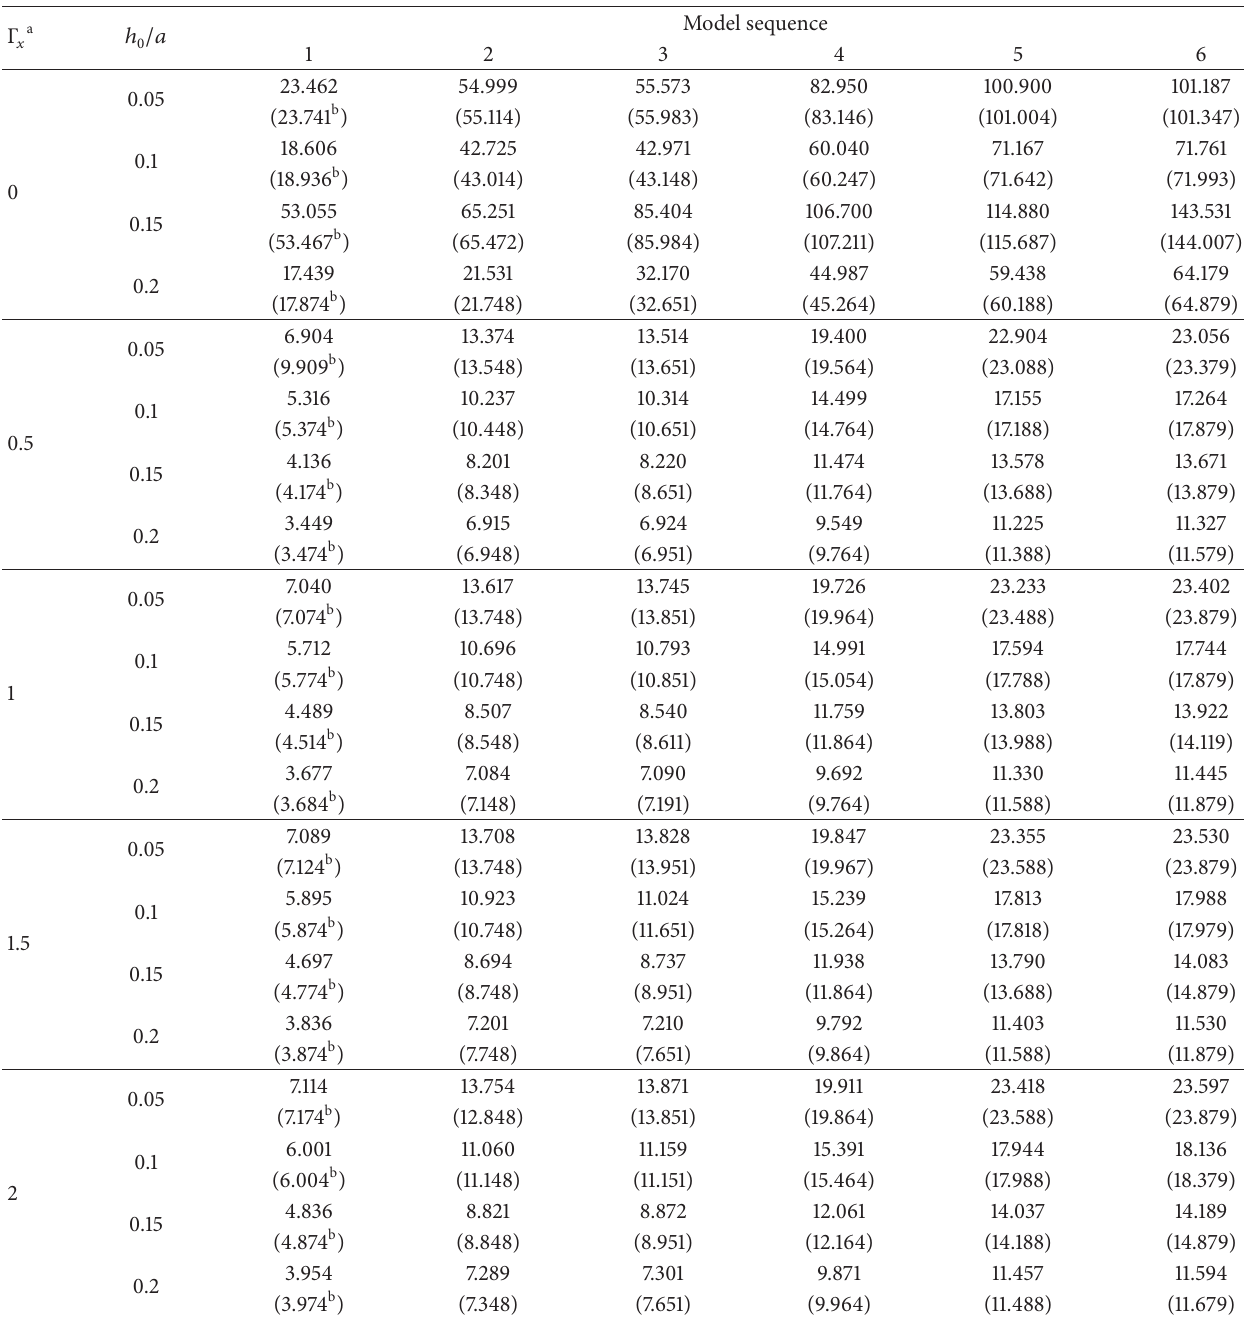
Table 10: Frequency parameter Ω = 𝜔𝑎 2 (𝜌ℎ 0 /𝐷 0 ) 1/2 for S-S-S-S moderately thick plates ( 𝑎/𝑏 = 1 ) with linearly varying thickness and elastic rotation support ( ℎ(𝑥,𝑦) = ℎ 0 (1 + 0.5𝑥 2 )(1 + 0.5𝑦 2 ) , 𝐾 𝑥0 = 𝐾 𝑥𝑎 = 𝐾 𝑦0 = 𝐾 𝑦𝑏 = Γ 𝑥